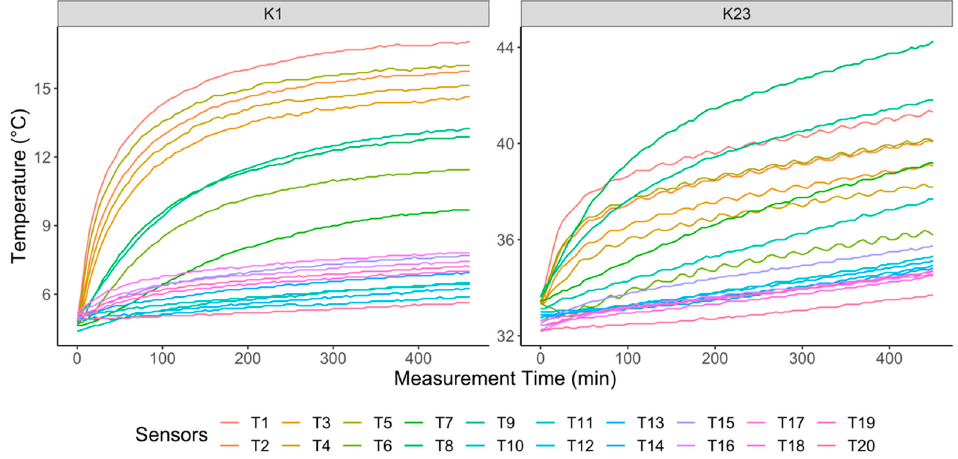
Figure 3. Temperature curves over measurement time on K1 and K23.